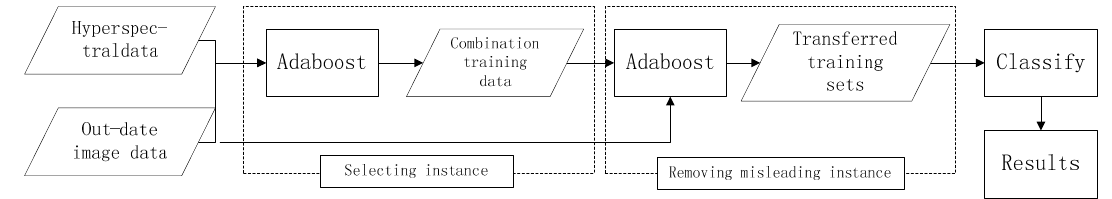
Figure 1. Framework of the classification scheme in this paper.